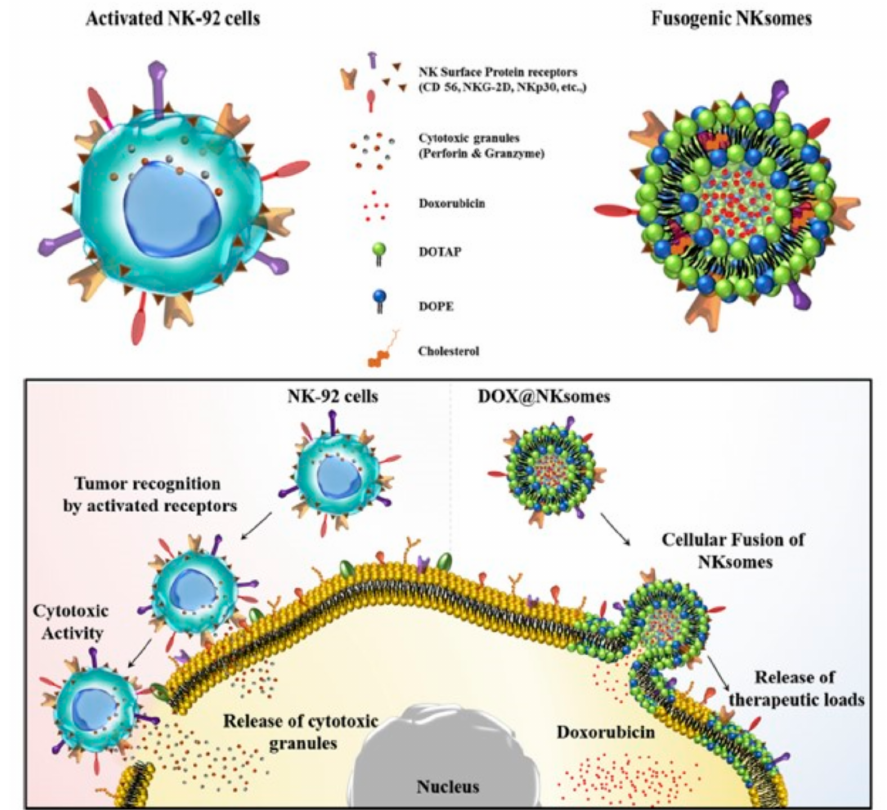
Figure 3. Illustration of target cancer therapy using activated natural killer (NK) cells and liposomes coated with NK membrane (NKsomes). Reproduced with permission from Ref.